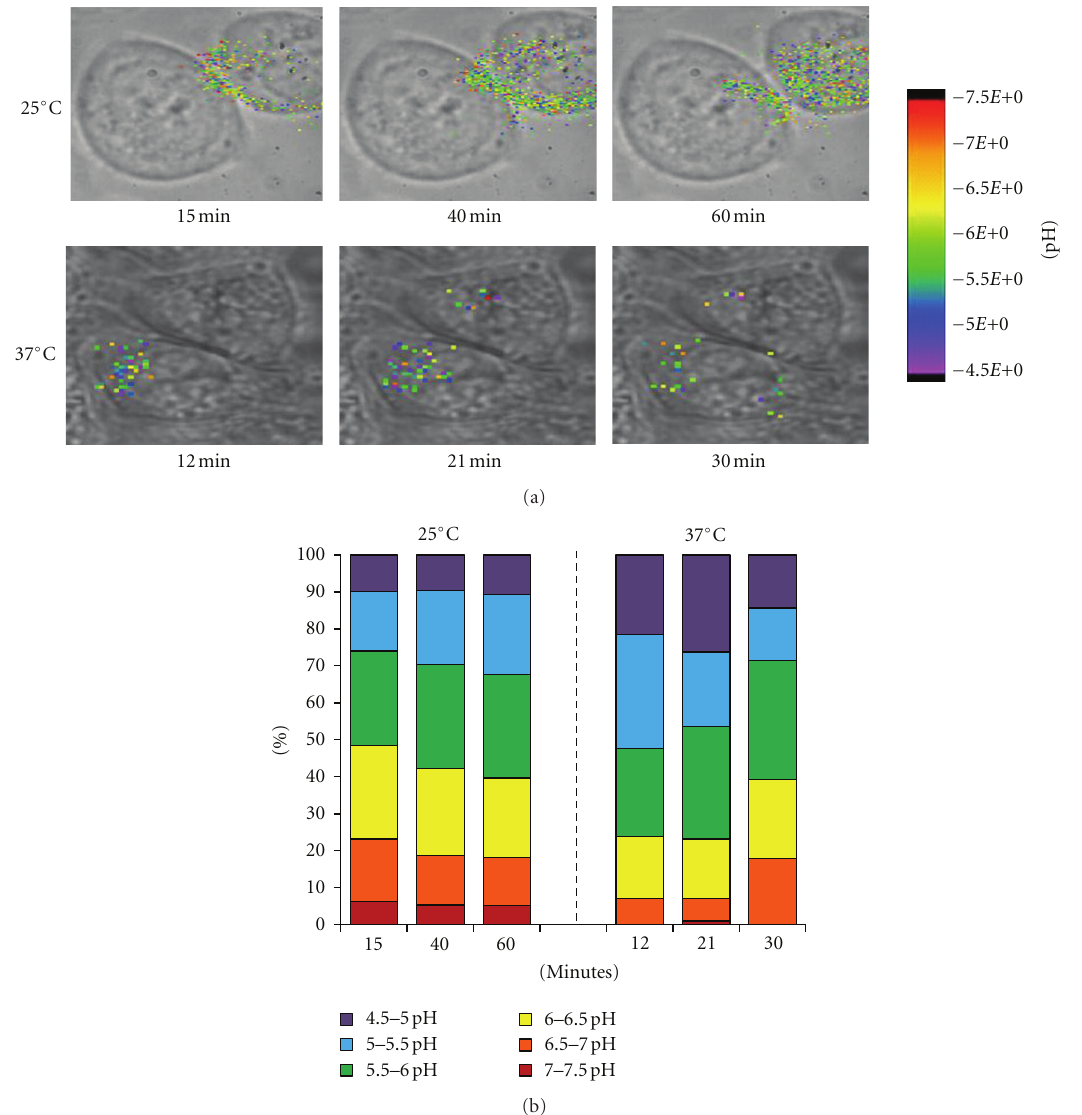
Figure 7: Temperature e ff ects on nanosensors at 37 ◦ C versus 25 ◦ C. (a) Whole-cell pH image maps of cells incubated at 25 ◦ C with 10-minutes incubation of nanosensors, followed by imaging at 15 (cid:4) , 40 (cid:4) , and 60 (cid:4) after the initial nanosensor addition. Bottom series are cells incubated at 37 ◦ C with 10-minute incubation with nanosensors followed by imaging at 12 (cid:4) , 21 (cid:4) , and 30 (cid:4) after initial nanosensor addition. (b) Bar graphs demonstrating percentage of nanosensors from whole, in each pH grouping, at specified time points. Cells were incubated for ten minutes with nanosensors and then imaged at specified time points. Reprinted with permission from Nowak-Lovato et al. [11] (copyright 2010